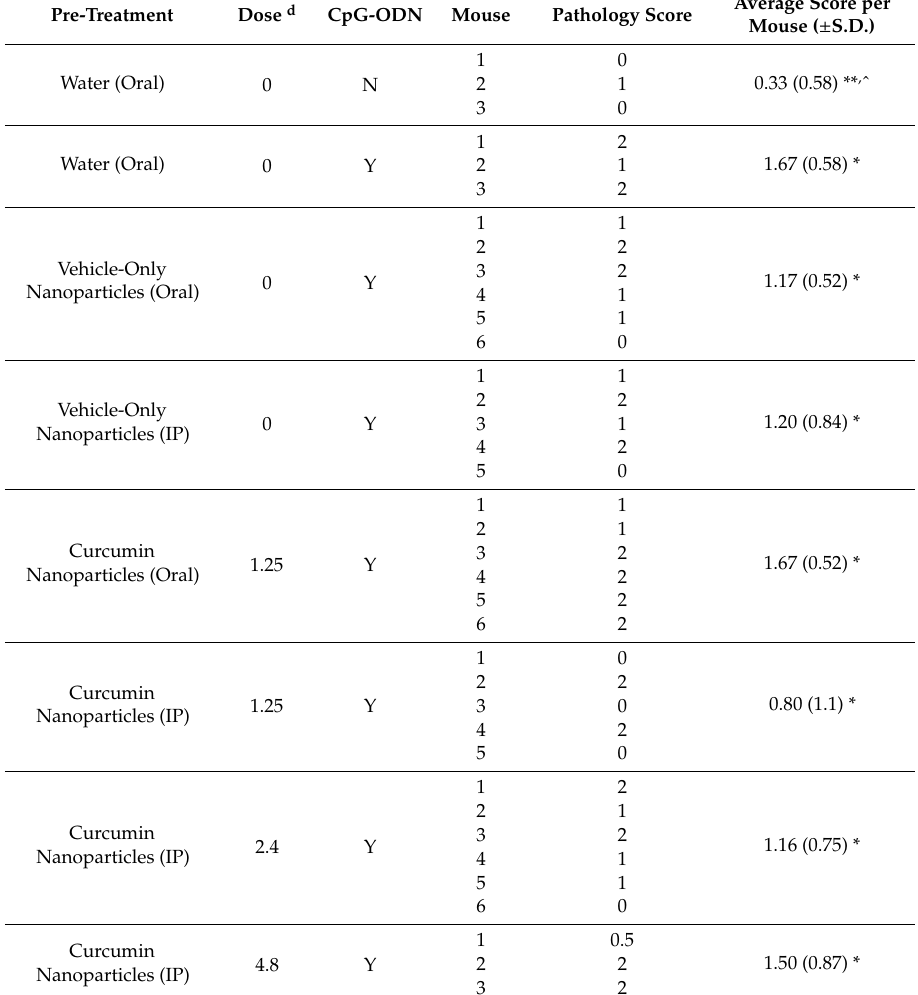
Table 1. Scoring of tissue inflammation following oral and intraperitoneal delivery of curcumin nanoparticles prior to inoculation with